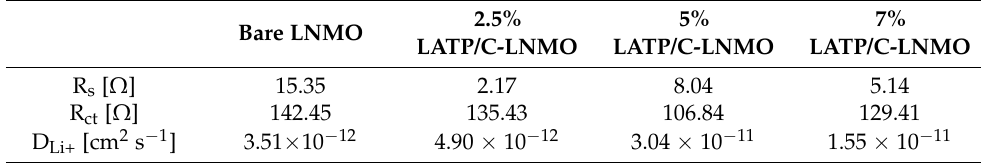
Table 2. Impedance data of bare LNMO and surface modified LATP/C-LNMO samples in equilibrium. Bare